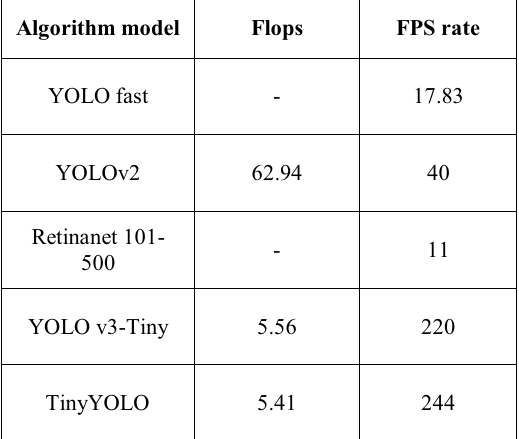
Table 2. Results of Frame rates and evaluation of the best algorithm to pair with AIoT Hardware. [20] Algorithm model